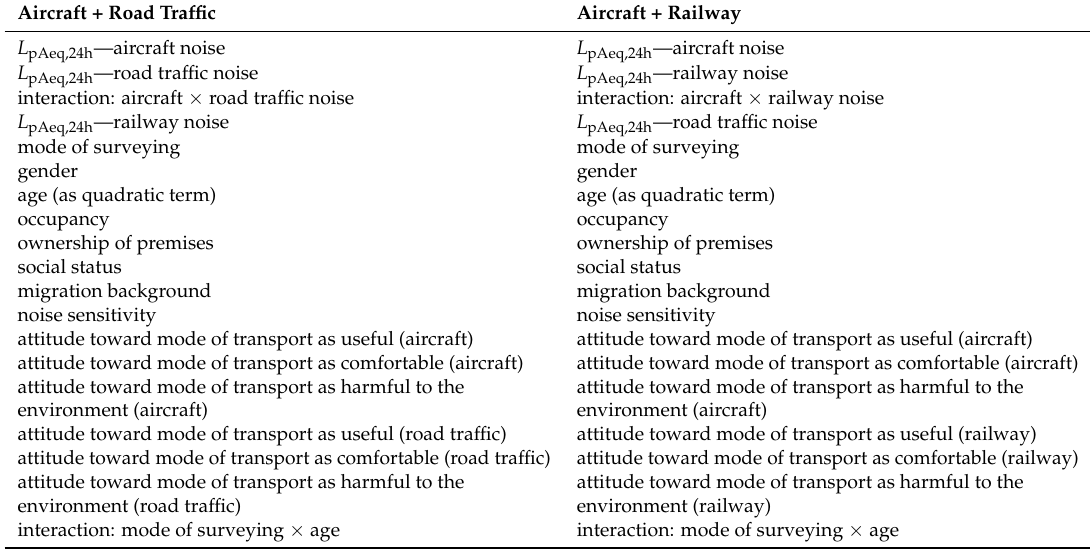
Table 6. Parameters of the multiple regression analysis of each